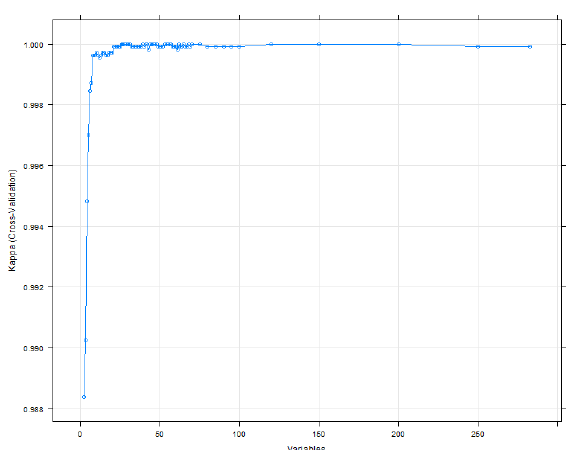
Figure 4. Plotting model performance against incrementally reduced data dimensionality to determine optimal feature subsets.